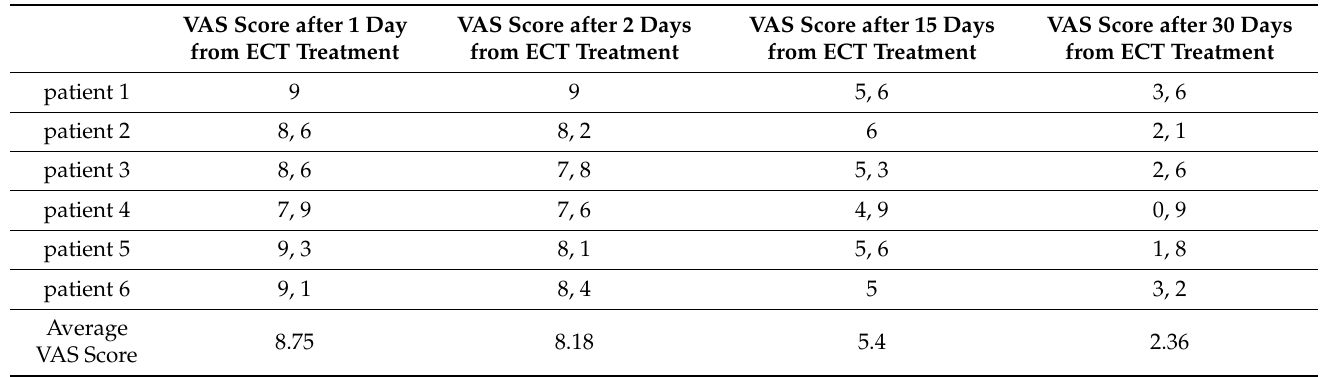
Table 2. Patients’ single and cumulative VAS scores regarding pain after ECT